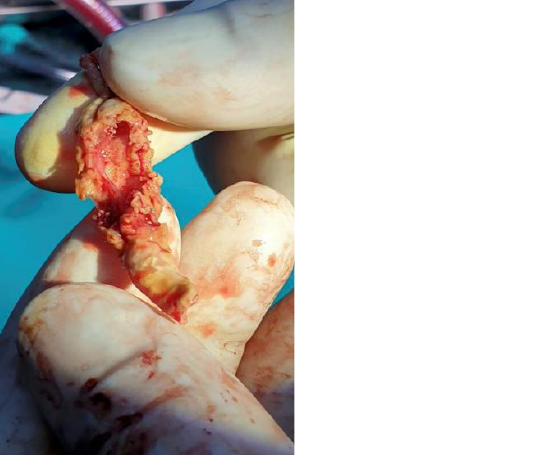
Figure 6. Operative view of the calcified fibrin sheath after extraction from the superior vena cava.